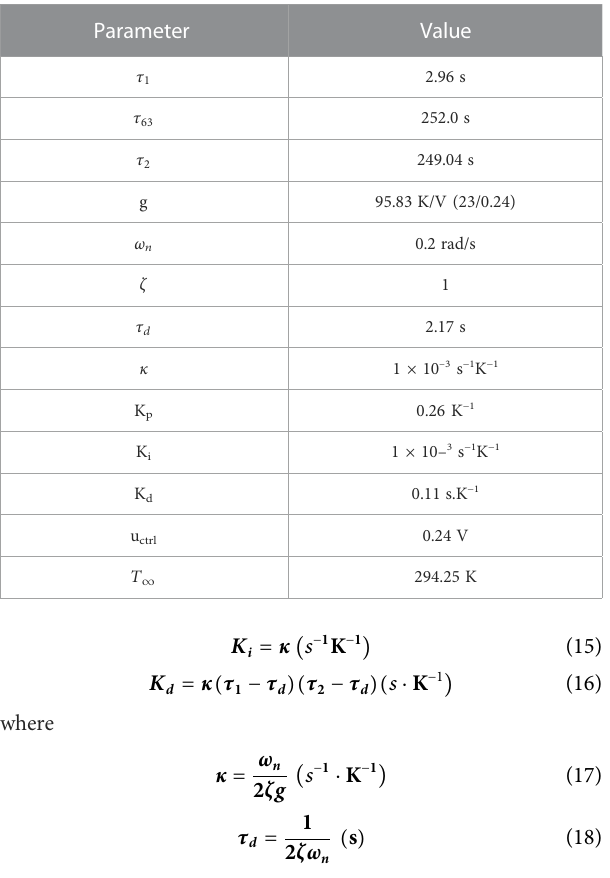
TABLE 2 Parameter list used in simulation of PID gains. Data sourced from Sharma et al. (2023).